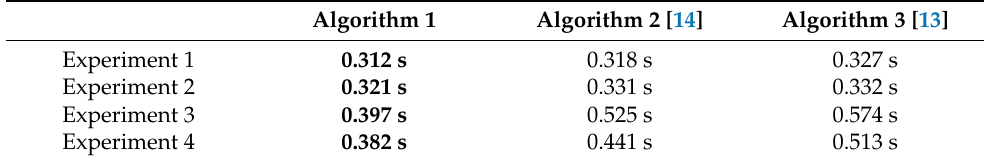
Figure 9. The results of Experiment 4. Table 2. The average computation